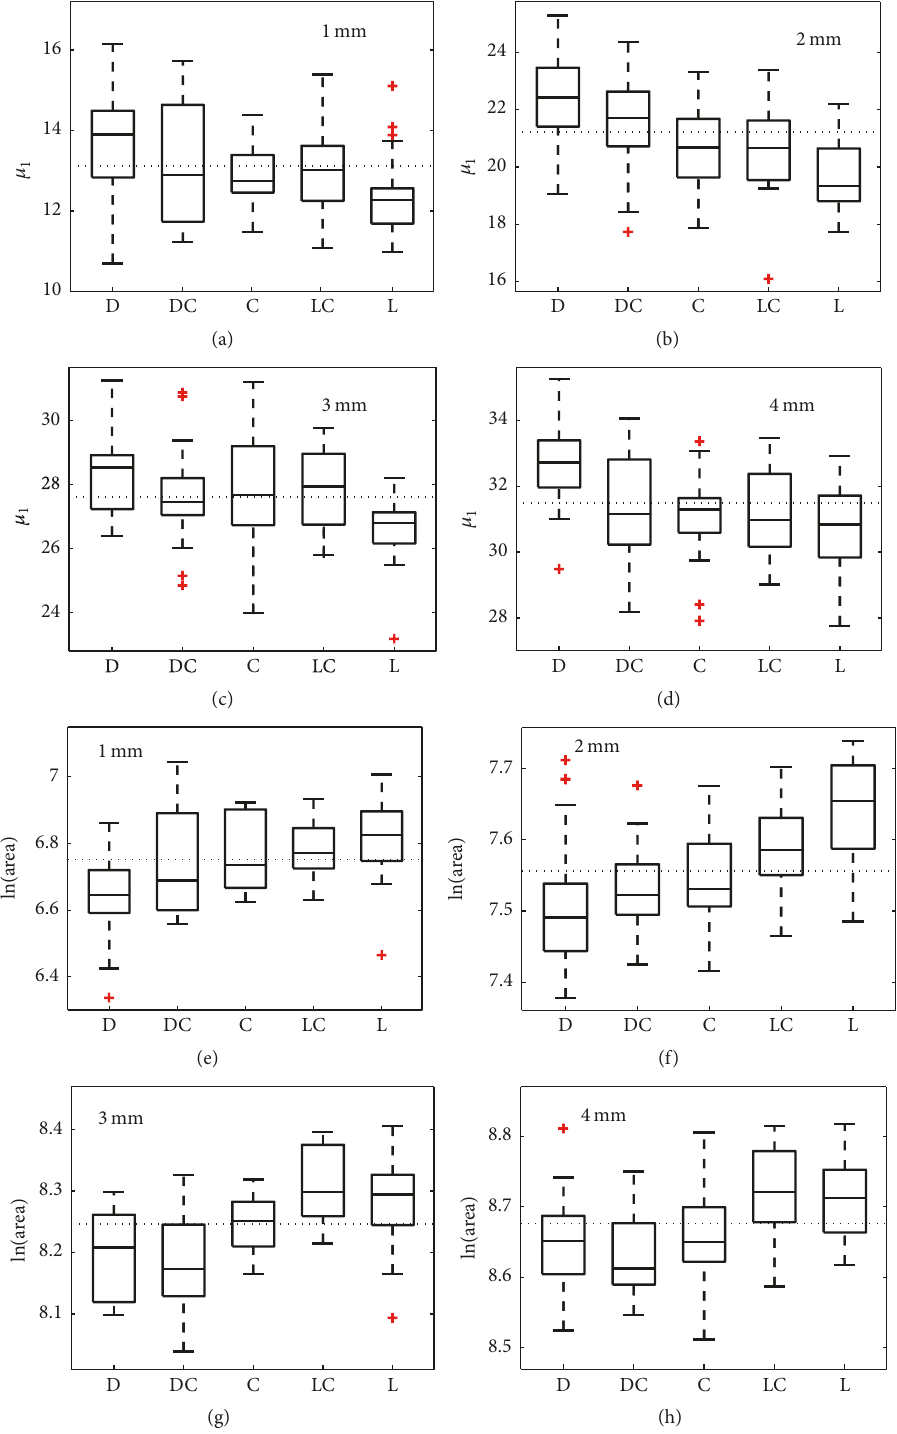
Figure 12: Influence of sampling location on image descriptors of particles.